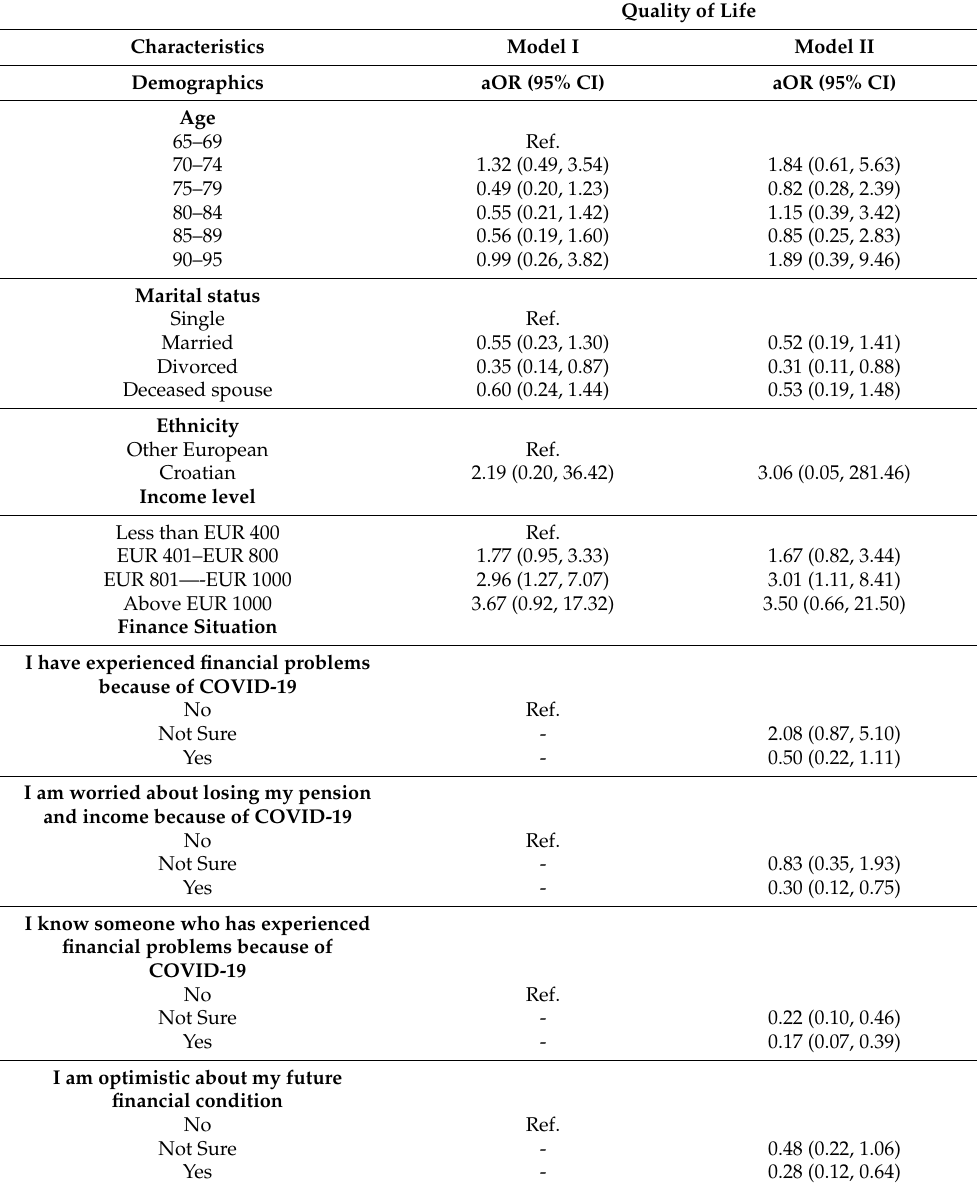
Table 4. Regression results for the Quality of Life of care home residents.